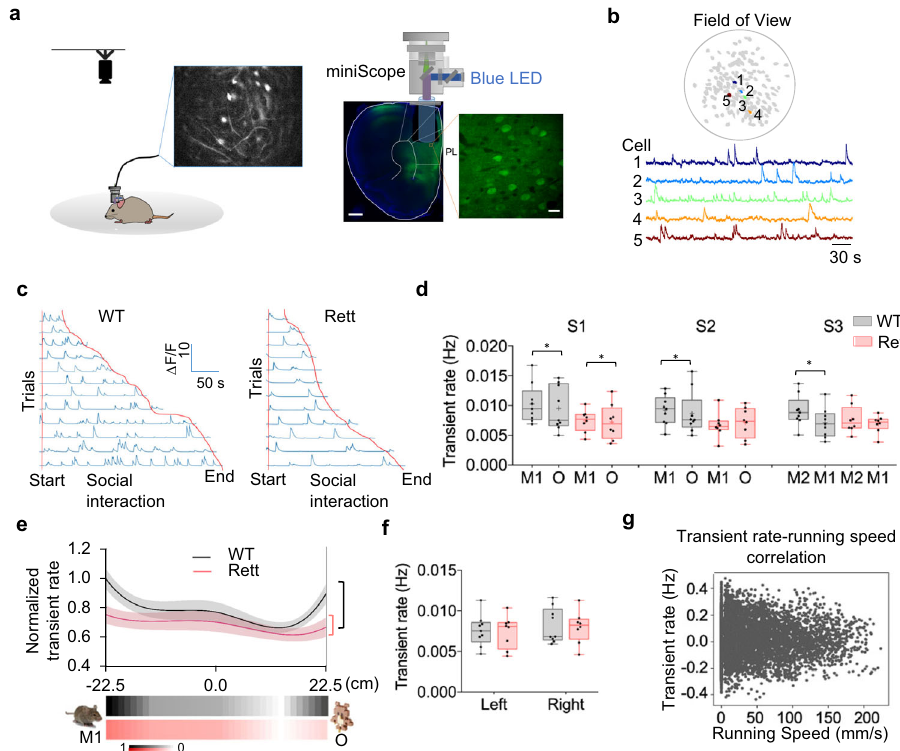
Fig. 2 Reduced transient rate of mPFC neural circuit is related to the lack of interest in social interactions of Rett mice. a Schematic of the experimental approach. Left: the calcium signal of the freely behaving mice in the chamber was imaged with a head-mounted miniature microscope, while behaviors were recorded by a high-speed camera. Middle: imaging setup and histology of the prelimbic (PL) region with GRIN lens implantation. Scale bar, 500 μ m. Right: confocal image of PL neurons showing GCaMP6m expression. Scale bar, 10 μ m. b Top: the fi eld of view under a GRIN lens in one mouse with identi fi ed neurons numbered and colored. Bottom: fl uorescence traces of example neurons marked in the above panel. c Responses of one representative neuron from a WT and a Rett mouse during social interactions in S1. Trials were organized by the length of interactions. d The averaged calcium transient rate when WT ( Mecp2 + / + ; n = 9) and Rett ( Mecp2 + / − ; n = 8) mice were engaged with different stimuli over the three sessions. Data are represented as mean ± SEM. * P < 0.05; ** P < 0.01, two-way ANOVA with Bonferroni – corrected post hoc comparisons. e Top: the response fi eld of the neural response. The normalized averge transient rates of WT ( n = 9) and Rett ( n = 8) mice for S1 are presented as solid lines, with standard error (SEM) conveyed by shaded regions (grey for WT, pink for Rett). Bottom: heatmap of the spatial fi eld of the averaged response of WT and Rett neurons. The red and black brackets to the right mark the high and low points of the Rett and WT curves, to highlight the difference in their dynamic ranges. f Averaged transient rate of mPFC neurons when WT ( n = 9) and Rett ( n = 8) mice were in two 10 cm ends of the central chamber, which showed no difference between genotypes. g Relationship between the transient rate of the mPFC neurons and the running speed (per 10 second bin) of one representative mouse. There was no signi fi cant correlation. Box boundaries in ( d ), ( f ) are the 25th and 75th percentiles, the horizontal line across the box is the median, the cross “ + ” indicates the mean value, and the whiskers indicate the minimum and maximum values. Source data are provided as a Source Data fi